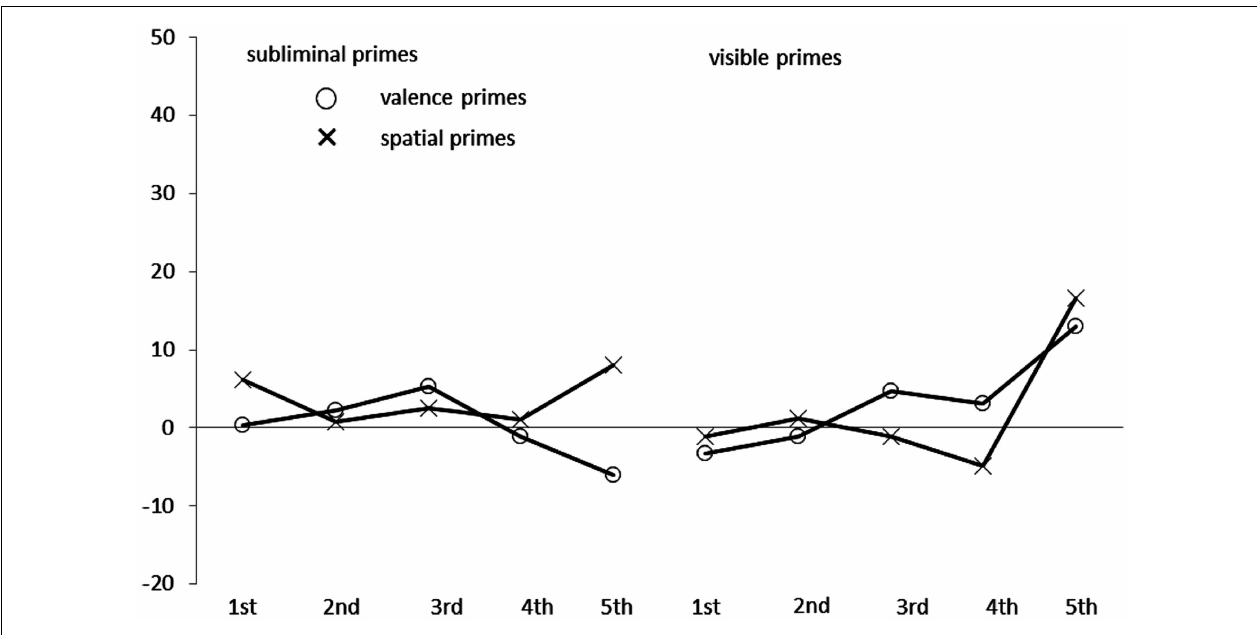
FIGURE 4 | Mean congruence effects in milliseconds, calculated as mean correct ReactionTimes (RTs in ms) of incongruent conditions minus mean correct RTs of congruent conditions in Experiment 3, as a function